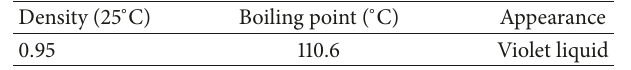
Table 4: Properties of cobalt